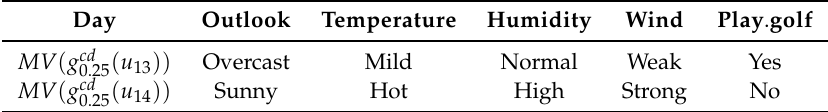
Table 5. Concept-dependent granular reflection of the exemplary training system from Table 1, in radius 0.25, 5 attributes, 2 objects; MV is Majority Voting procedure (the most frequent descriptors create a granular